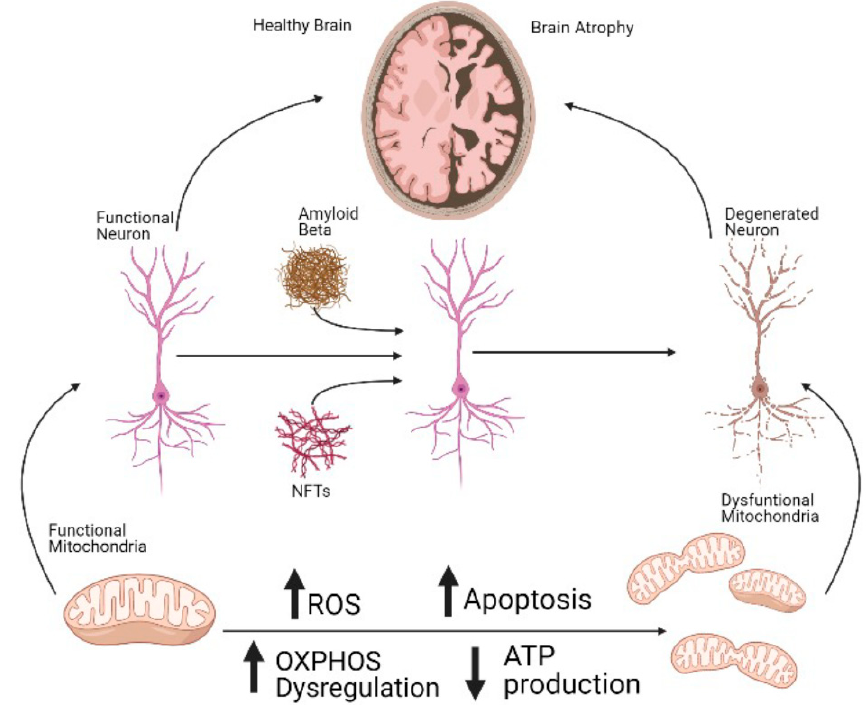
Figure 1. Mitochondrial dysfunction is an early, crucial component of cell death in AD. Dysregulated OXPHOS, including the dysfunction of the ATP synthase, induces decreased ATP production and increased ROS. This will ultimately lead to a rise in the rates of apoptotic cell death not only in neurons but also in other cell types in the central nervous center. The increased death of cells will induce serious damage in the brains of the patients, which correlates with the symptoms of the disease. Interestingly, mitochondrial dysfunction, including dysregulated OXPHOS, is an early event in AD, preceding the accumulation of A β and the presence of NTFs. ↑ upregulated; ↓ downregulated.